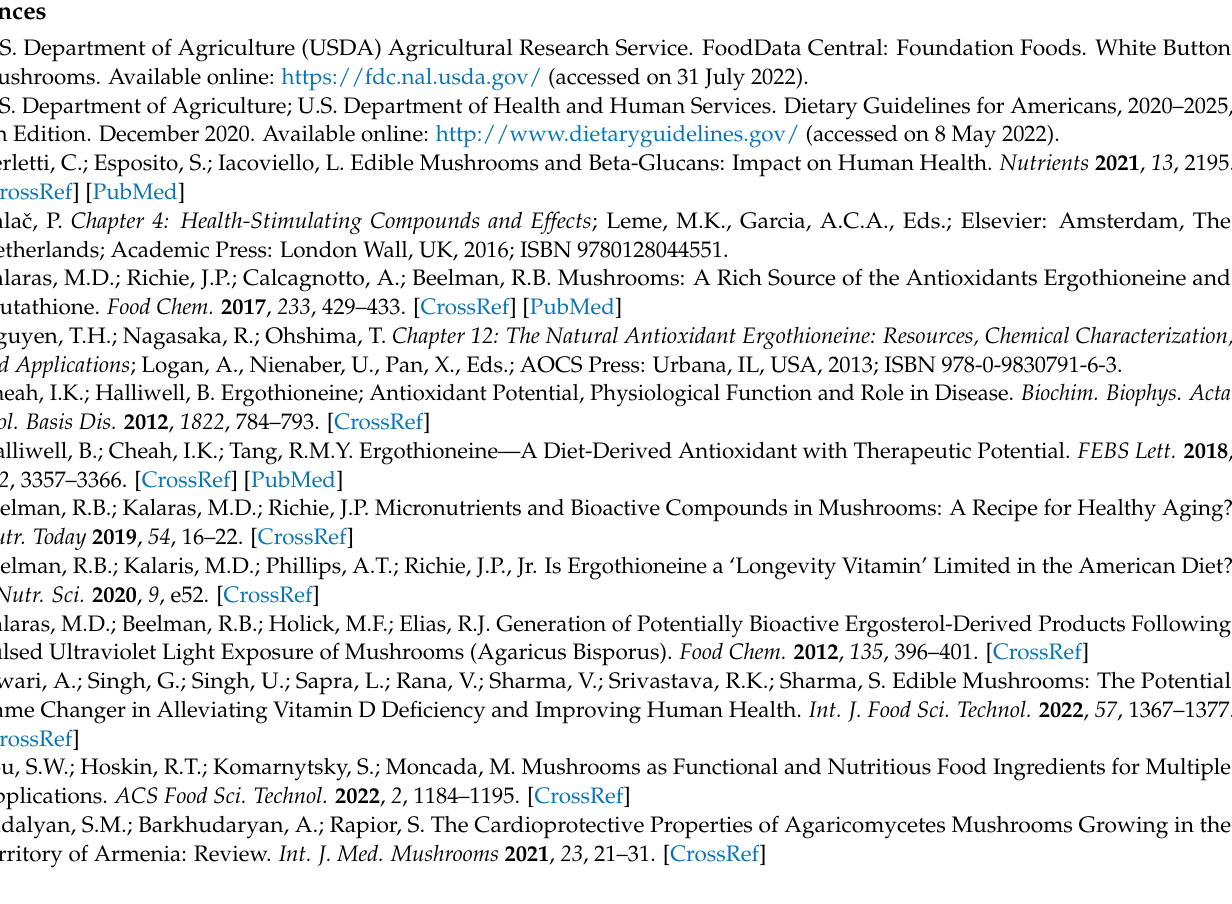
Control Studies, Table S5: Change in Systolic Blood Pressures (mmHg), Table S6: Change in Diastolic Blood Pressures (mmHg), Table S7: Change in Total Cholesterol (mg/dL), Table S8: Change in HDL Cholesterol (mg/dL), Table S9: Change in LDL Cholesterol (mg/dL), Table S10: Change in Triglycerides (mg/dL), Table S11: Change in Fasting Glucose (mg/dL), Table S12. Change in HbA1c (%), Table S13: Change in hs-CRP